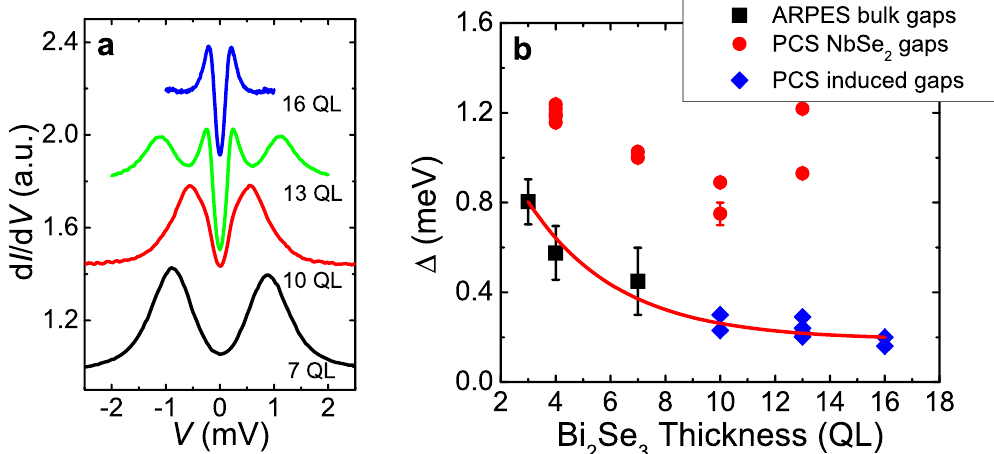
Figure 2. Point contact spectra of NbSe 2 /Bi 2 Se 3 heterostructures of different Bi 2 Se 3 thicknesses. ( a ) Normalized conductance spectra of point contacts on NbSe 2 /Bi 2 Se 3 samples of different Bi 2 Se 3 thicknesses at ~0.1 K. The R n values are 485 Ω, 71 Ω, 26 Ω, and 57 Ω, respectively. Curves are shifted vertically for clarity. ( b ) Energy gaps from point contact measurements plotted together with bulk state gaps from ARPES measurements on the NbSe 2 /Bi 2 Se 3 heterostructures of various Bi 2 Se 3 film thicknesses. The red line is a guide for the